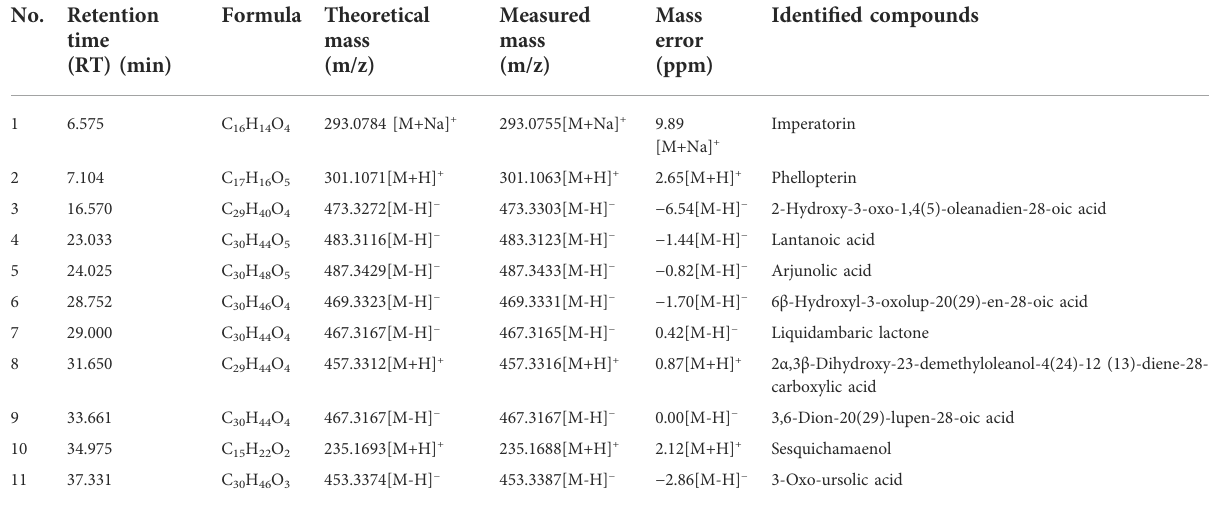
TABLE 1 Prototype blood component of